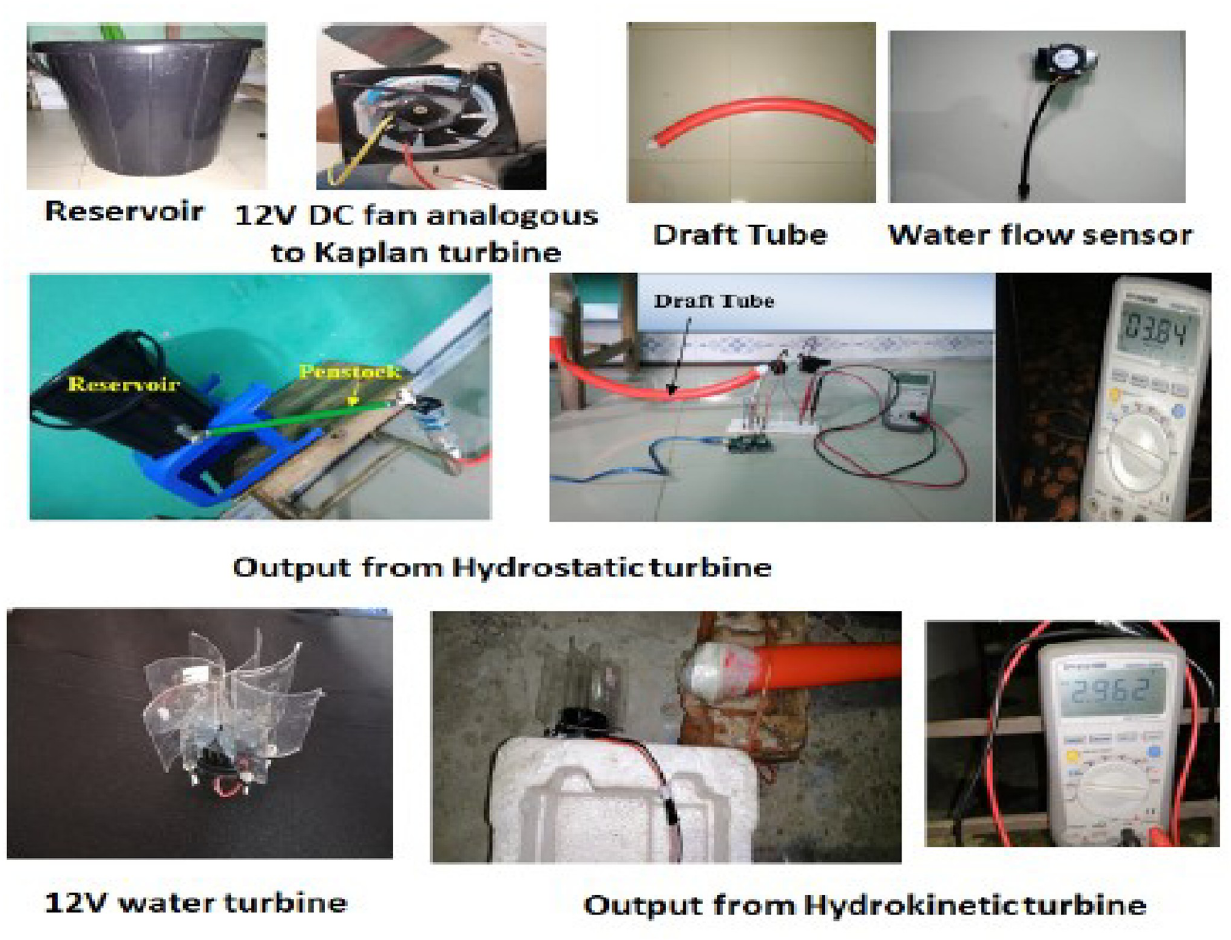
Fig 11. Proposed prototype model is in a small